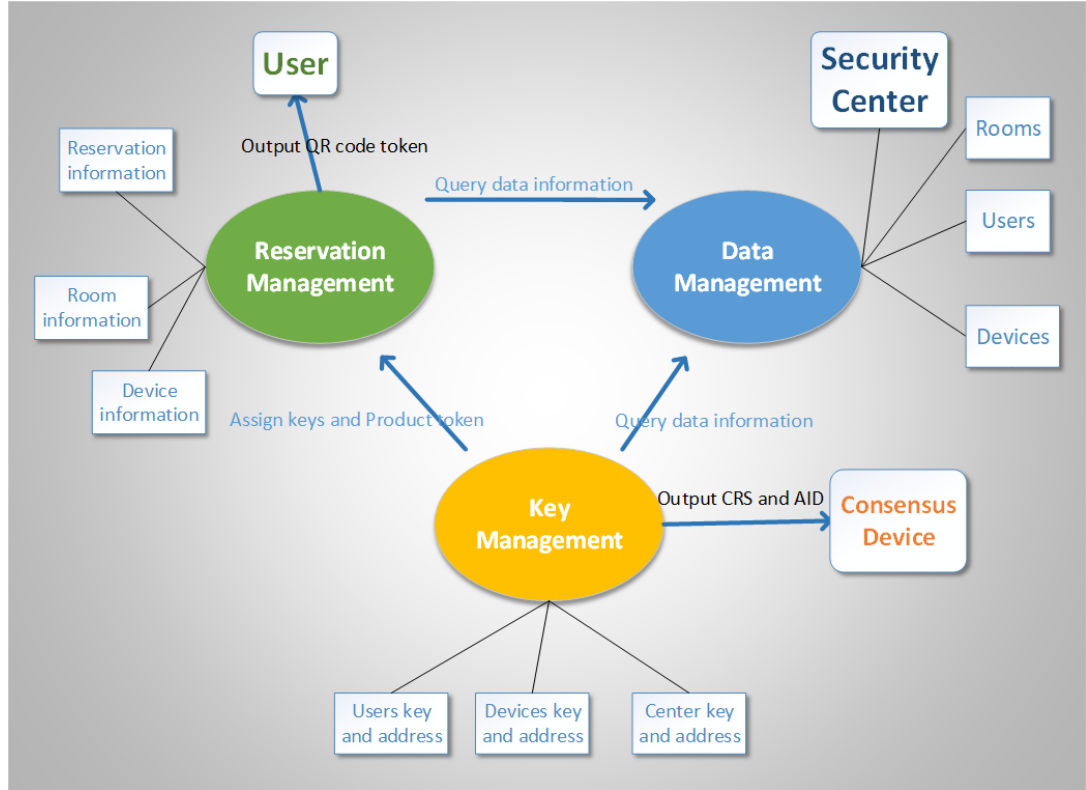
Figure 4. Data governance of the three-system decentralization model